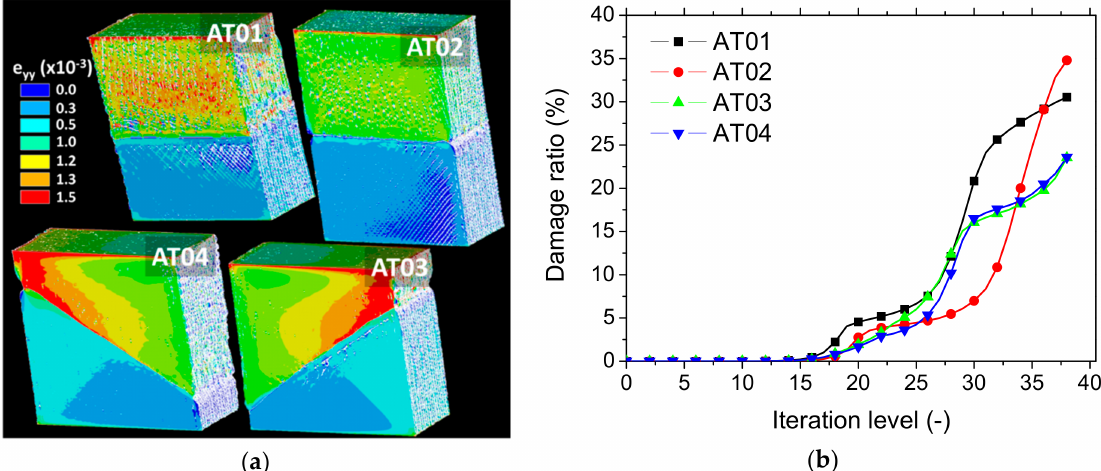
Figure 19. Finite element results: ( a ) stress intensity evolution as a function of the printing conditions and the level of damage; ( b ) damage ratio evolution for all printing